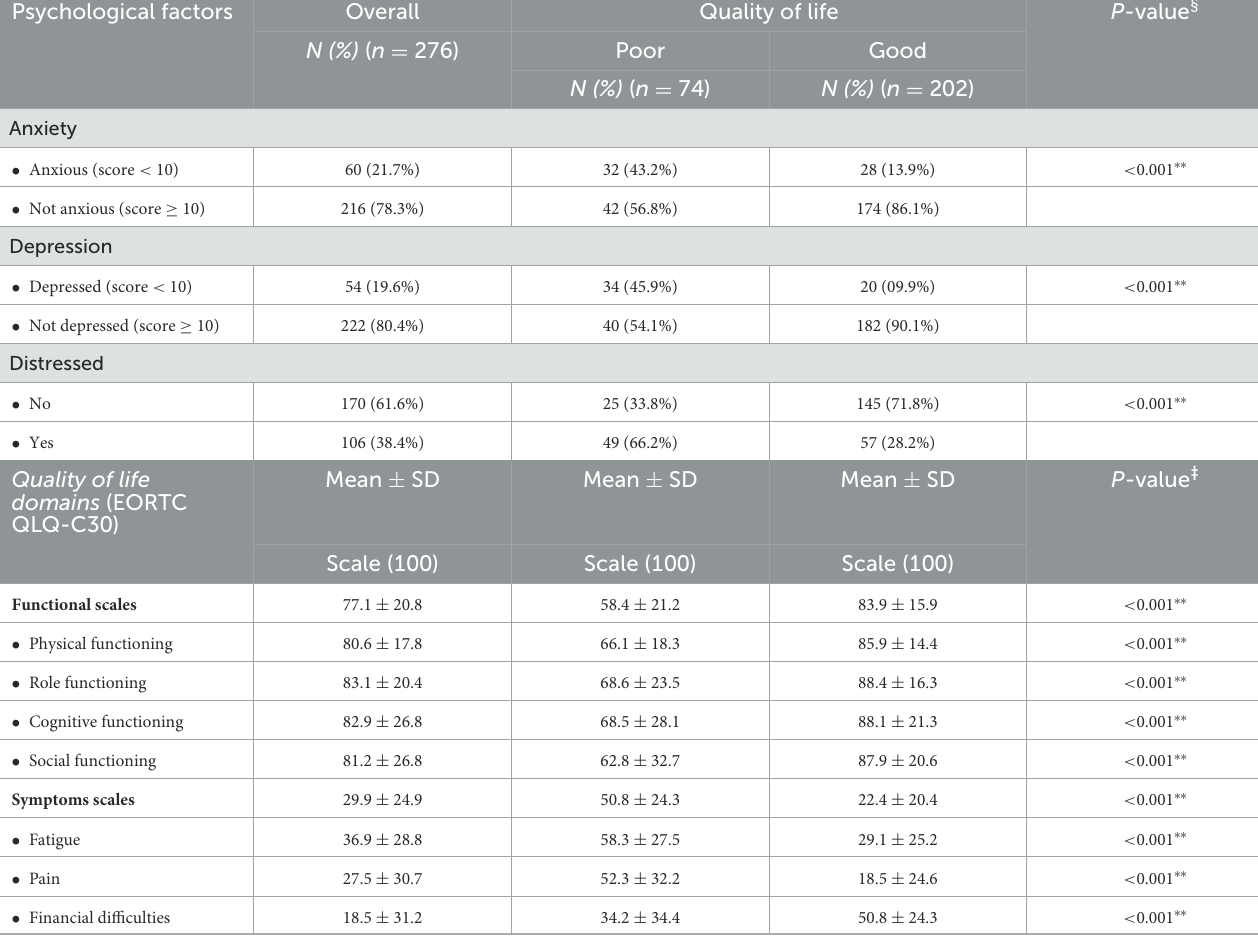
TABLE 3 Assessment of psychological factors in relation to quality of life among cancer patients. Psychological factors Overall Quality of life P -value § N (%) ( n = 276) Poor Good N (%) ( n = 74) N (%) ( n =